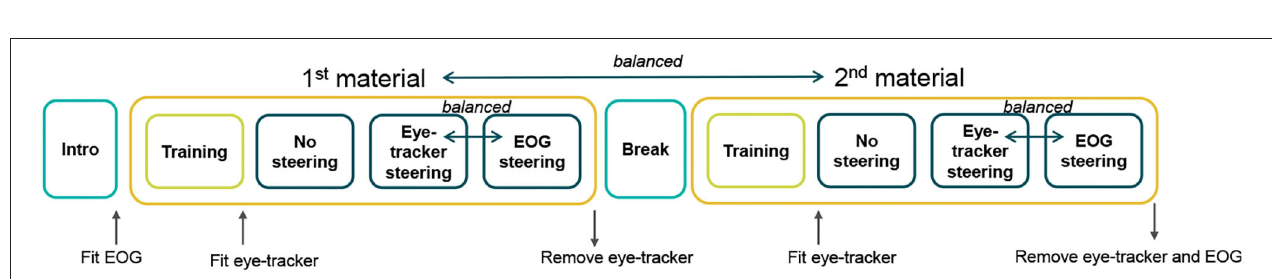
FIGURE 3 | Schematic overview of the test setup with Vicon motion capture cameras, Tobii Pro eye-tracking Glasses 2 used to measure gaze, the Mobita EEG amplifier used to record in-ear EOG signals, and the 88 inches 4K TV used to present life-sized persons in the video stimuli. The two green loudspeakers present the conversation material and are spatially aligned with the two speakers on the TV while the eight red loudspeakers present babble noise.